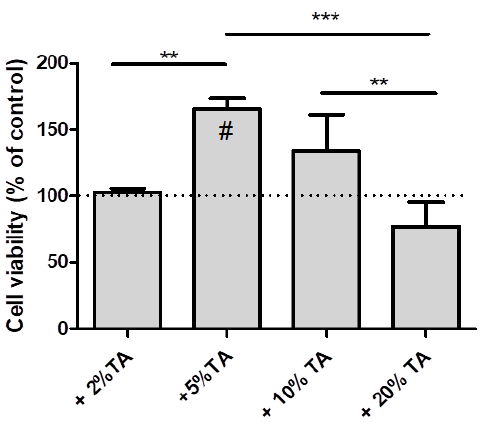
Figure 10. hPDL cells viability on tested hydrogels after 24 h of culture. Results are expressed as percentage change in cell viability compared to control hydrogel. # indicates significant increased from control. Statistically significant differences (** p ≤ 0.05; *** p ≤ 0.001) within the groups.